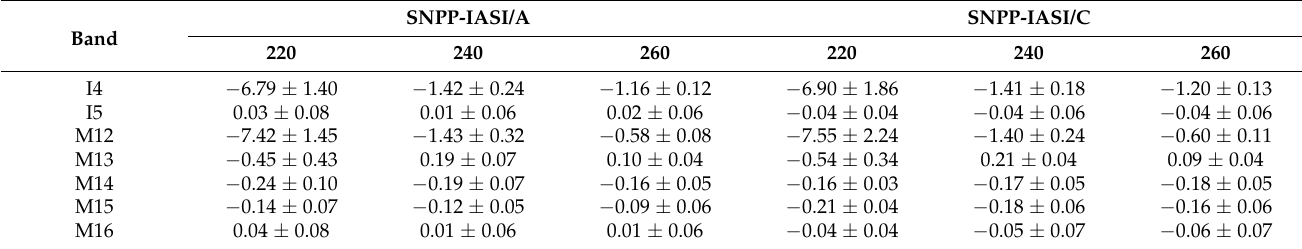
Table 6. Average ∆ BT between SNPP VIIRS and IASI-A/C at different BT levels. All units are in Kelvin.